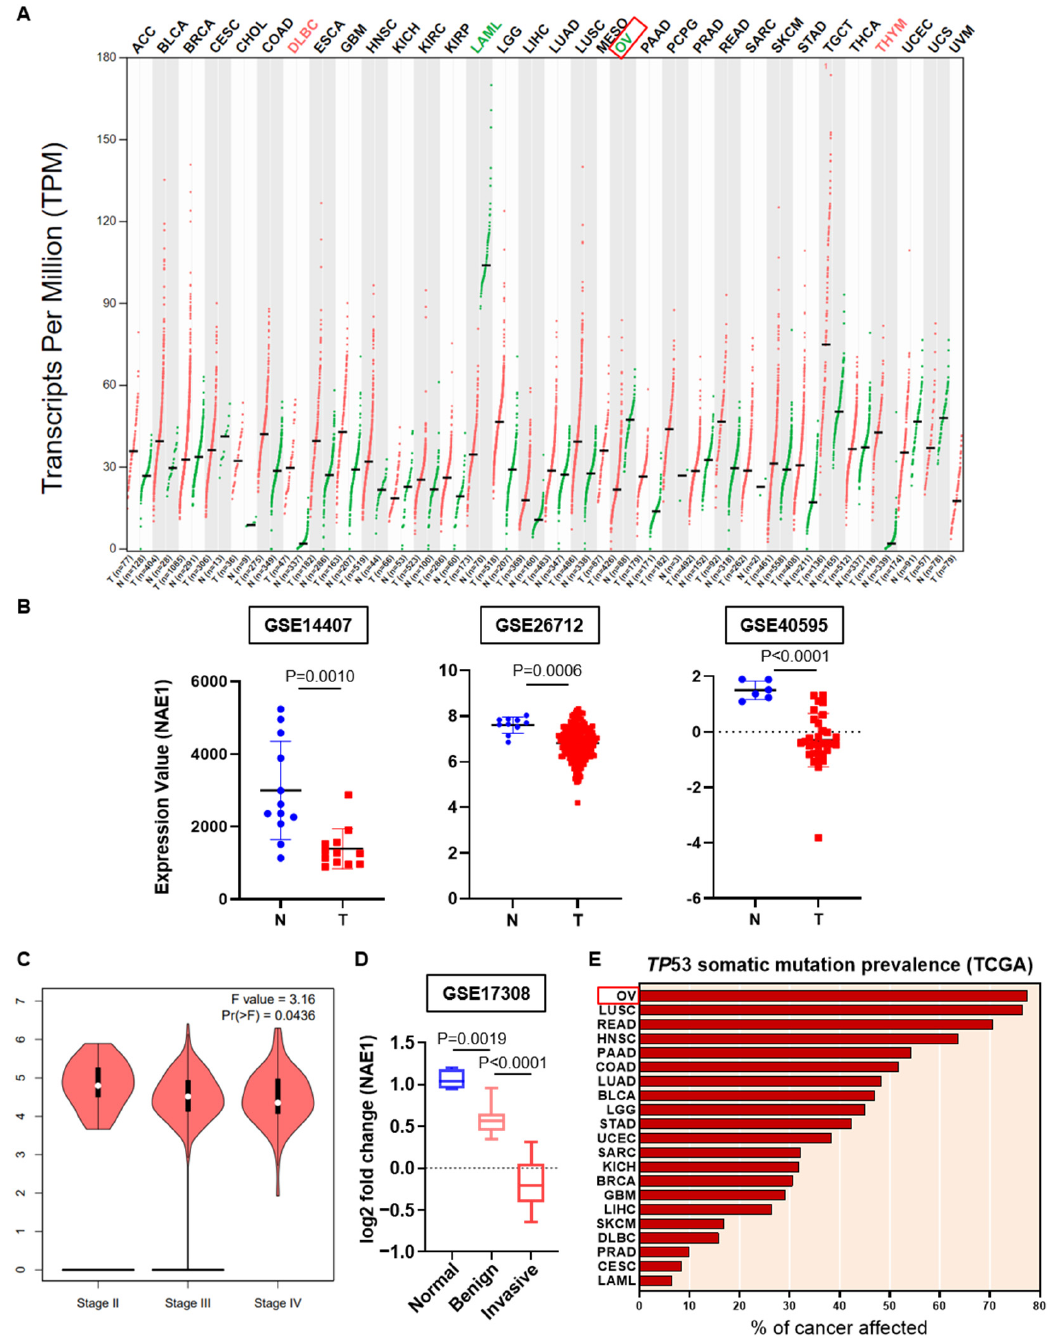
Figure 2. Associations of NAE1 expression, the pathological stage, and TP53 mutation prevalence in ovarian tumors. ( A ) Expression level (transcript per million: log2(TPM + 1)) of NAE1 between TCGA tumors (red dots) and TCGA normal, and GTEx normal data (green dots) in 27 cancer types using Gene Expression Profiling Interactive Analysis (GEPIA). T: Tumor; N: Normal; n: number. ( B ) Distribution of NAE1 expression in normal ovarian surface epithelium (blue circles) and serous ovarian cancer epithelium (red squares) (GSE14407, GSE26712, GSE40595). ( C ) Violin plot indicating the correlation between NAE1 expression and pathological stage in patients with ovarian cancer (GEPIA). The p -value was set at 0.05. ( D ) Log2 fold change of NAE1 mRNA expression in ovarian surface epithelium (blue box), benign ovarian serous tumors (pink box), and invasive ovarian serous tumors (red box) (GSE17308). ( E ) TP53 somatic mutation prevalence in TCGA data were downloaded from the International Cancer Genome Consortium (ICGC) web portal.